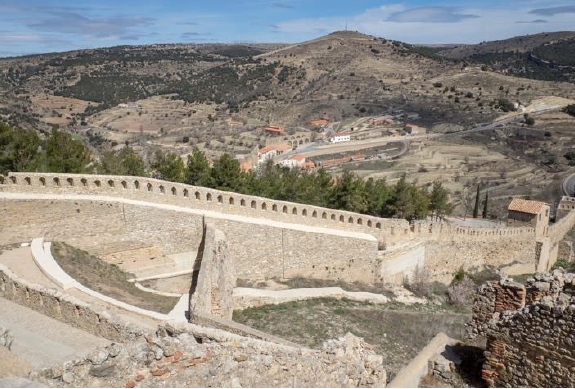
Figure 5. Section of the wall with a steep slope, between the Portal de la Nevera and the Castle (Source: S. Portela,